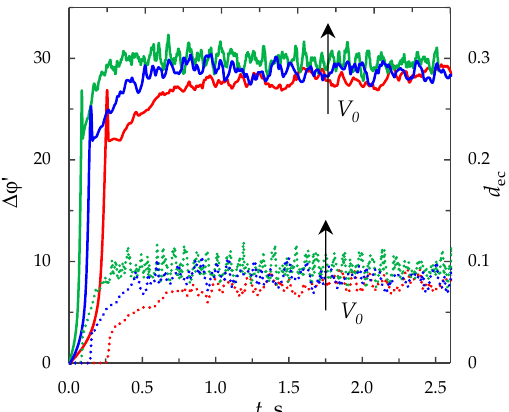
Figure 13. ChP (solid lines) and the average thickness of the electroconvective mixing layer, d ec (dotted lines). The results of computation for V 0 = 3.8 × 10 − 3 m/s (red lines), 7.6 × 10 − 3 m/s (blue lines), 15.2 × 10 − 3 m/s (green lines) at current density i av / i lim = 2.